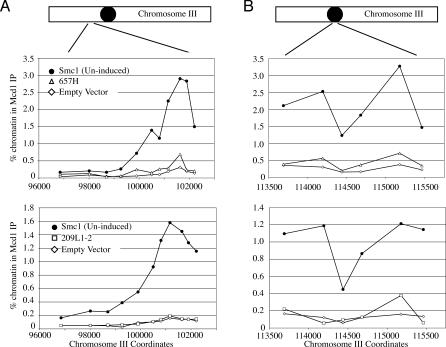
657H and 209L1–2 Disrupt CAR Enrichment of CohesionCultures of YMM11 (smc1–2 MCD1-HA) cells containing minichromosomes with different Smc1 alleles were grown and arrested in metaphase (Figure 4C, see legend). Cells were processed for ChIP (see Materials and Methods). Mcd1-HA binding at specific chromosomal loci was analyzed by PCR. Data shown is for (A) the CARC1 locus, located 11 kb from the centromere of Chromosome III, and (B) 2 kb surrounding CENIII.